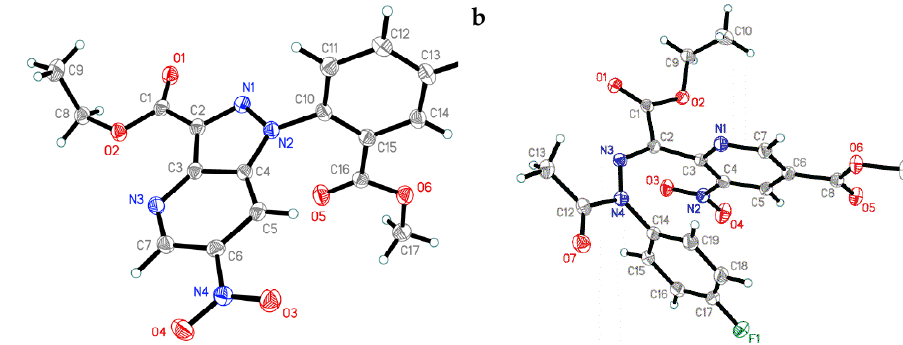
Figure 5. X-ray crystal structures of compounds ( a ) 5c and ( b ) the intermediate 5q’ (only one of two crystallographically unique molecules is shown) with thermal ellipsoids at 50% probability level.